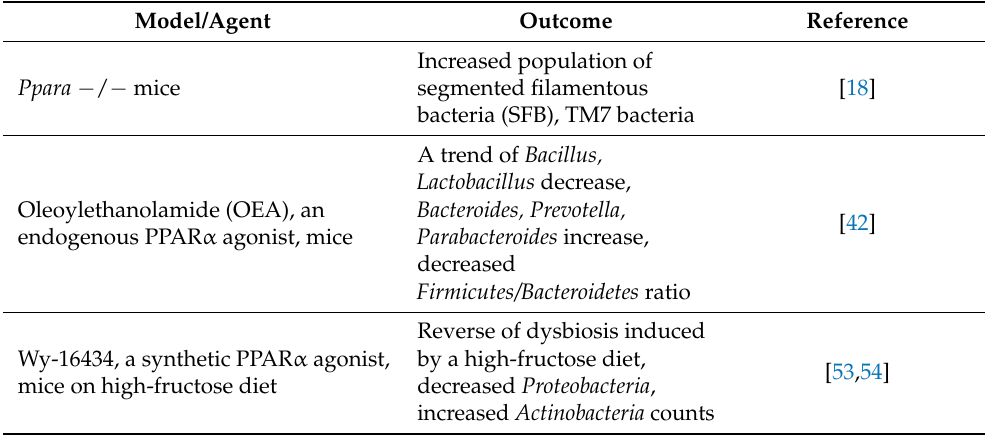
Table 1. The experimental evidence of PPAR α -mediated modulation of gut microbiota. Model/Agent Outcome